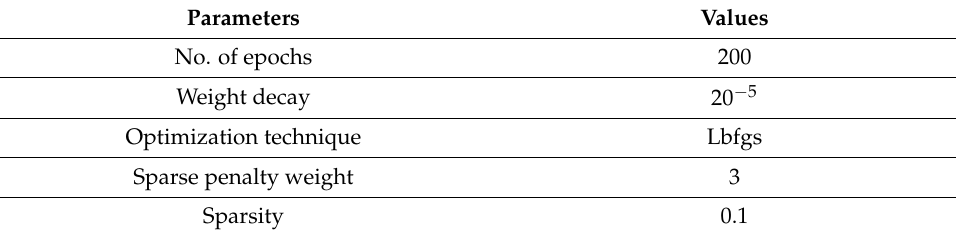
Table 3. Sparse autoencoder